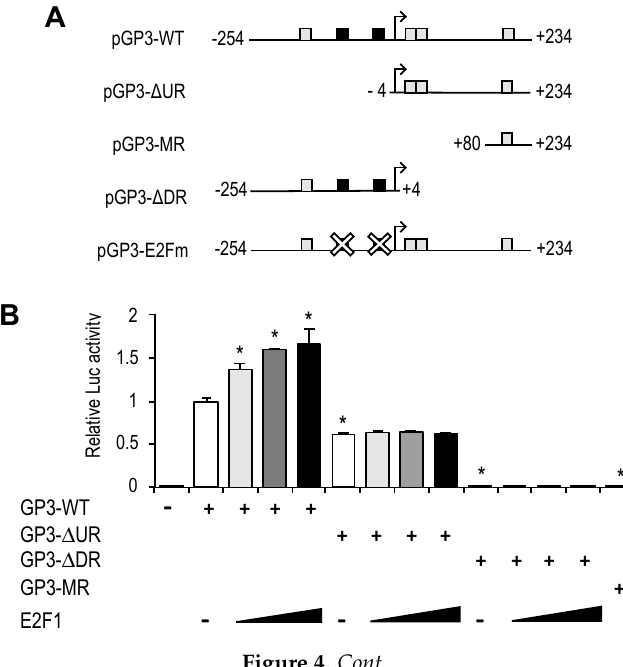
Figure 4. E2F binding motifs function as negative and positive regulatory elements. ( A ) Promoter-luciferase constructs of GOLPH3 and its derivatives. Mutant motifs are depicted with a white cross. ( B ) Asynchronous U2OS cells were transfected with the indicated luciferase reporter constructs along with pRL-TK and various amounts of a plasmid expressing E2F1 (50 ng, 150 ng, 250 ng) per well in a 12-well plate. Values are represented as luciferase activities relative to pGP3-WT activity of cells transfected with empty pCMV control. ( C ) U2OS cells were transfected with the indicated reporter constructs along with pRL-TK and synchronized in mitosis. Subsequently, cells were released into the cell cycle and luciferase values were calculated as relative values of firefly luciferase activities relative to Renilla activities in each sample. ( D ) Asynchronous U2OS cells were transfected with the indicated reporter constructs and various amounts of a plasmid expressing E2F1 (50 ng, 250 ng). Values are represented as luciferase activities relative to pGP3-WT activity of cells transfected with empty pCMV control. Shown are the results of a representative experiment of two independent experiments. *, p < 0.05. 3.4. A CREB/ATF Site in the GOLPH3 Promoter Regulates Steady-State GOLPH3 Expression The bioinformatic analysis identified several CREB/ATF motifs in the regulatory region of GOLPH3 . One motif is located in the region upstream of the transcriptional initiation site, and three more are located downstream of it (Figure 2A). To further investigate the transcriptional regulation of GOLPH3 gene, we constructed a plasmid lacking the 5 ′ UTR sequence by